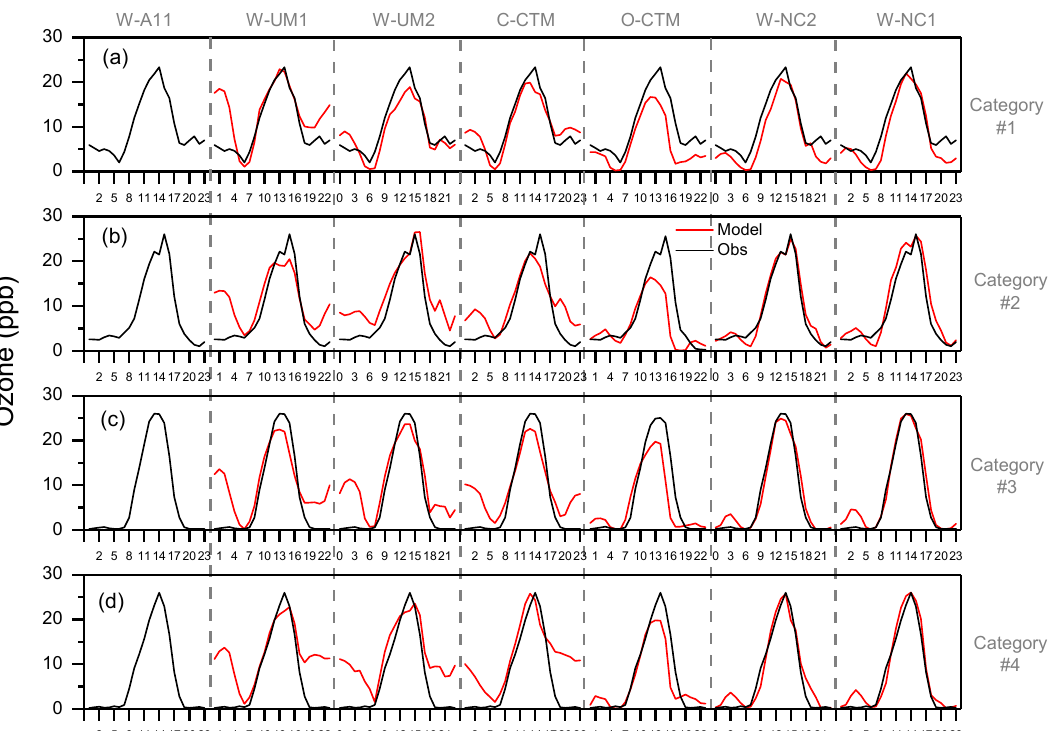
Figure 18. Mean bias (µ MB ) and σ MB for ( a ) NO, ( b ) NO 2 , ( c ) O 3 , ( d ) CO, ( e ) PM 10 , and ( f ) SO 2 , at Westmead for all models and atmospheric mixing states. 3.6.5. Summary of Model Performance for Selected Air Pollutants A summary of µ MB and σ MB values for all chemical species discussed in Sections 3.6.2–3.6.4, separated by mixing state, is given in Figure 18. In this format, between-model differences are clear for each species and mixing state, making it easier to infer which mixing states have the largest influence on perceived model skill. Furthermore, where similarities in behavior between species exist, as is the case for NO and CO in Figure 18a,d, these are also clearly evident. For the locally-sourced primary pollutants (NO and CO) there was a tendency for models to underestimate concentrations on category #3 and #4 days averaged across the diurnal cycle. Most of this discrepancy was attributable to underestimated morning and evening peak concentrations. In the case of NO 2 , which has both primary and secondary sources, no comparable dependence of µ MB on mixing state was evident (Figure 18b). The absolute magnitude of PM 10 µ MB as well as its σ MB typically increased from category #1 to #4 conditions. In the case of ozone, with purely secondary